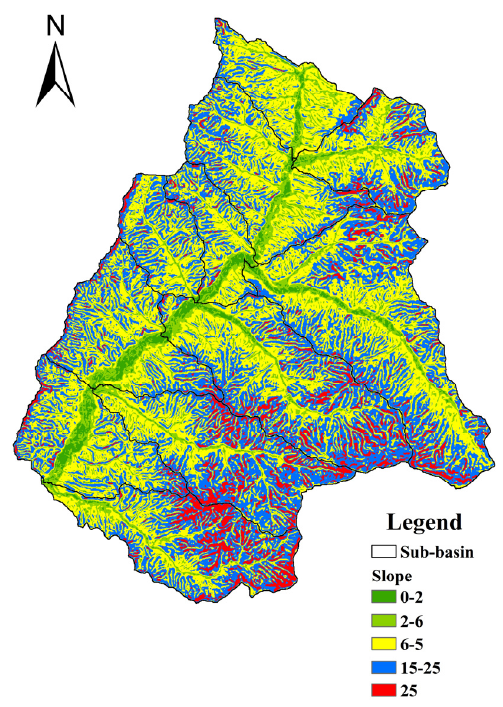
Figure 3. The slope map of Gedong basin.